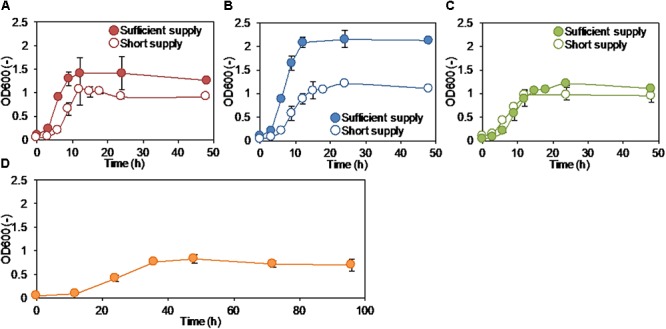
Growth curves of strain S05 when cultured with (A) anode electrode, (B) oxygen, and (C) nitrate as a sole external electron acceptor, respectively. The culture condition with anode electrode regulated the potential at +0.2 V (vs. Ag/AgCl), ambient air at a flow rate of 25 L/h, and 2 ml of 6 M NaNO3 solution per a day were categorized as sufficient supply, while those with electrode not regulated the potential, 2% O2 gas (pure N2/Air = 4:1) at a flow rate of 0.45 ml/min, and 1 ml of 0.6 M NaNO3 solution per a day were categorized as short supply, respectively. The growth curve without any electron acceptor was described in (D).